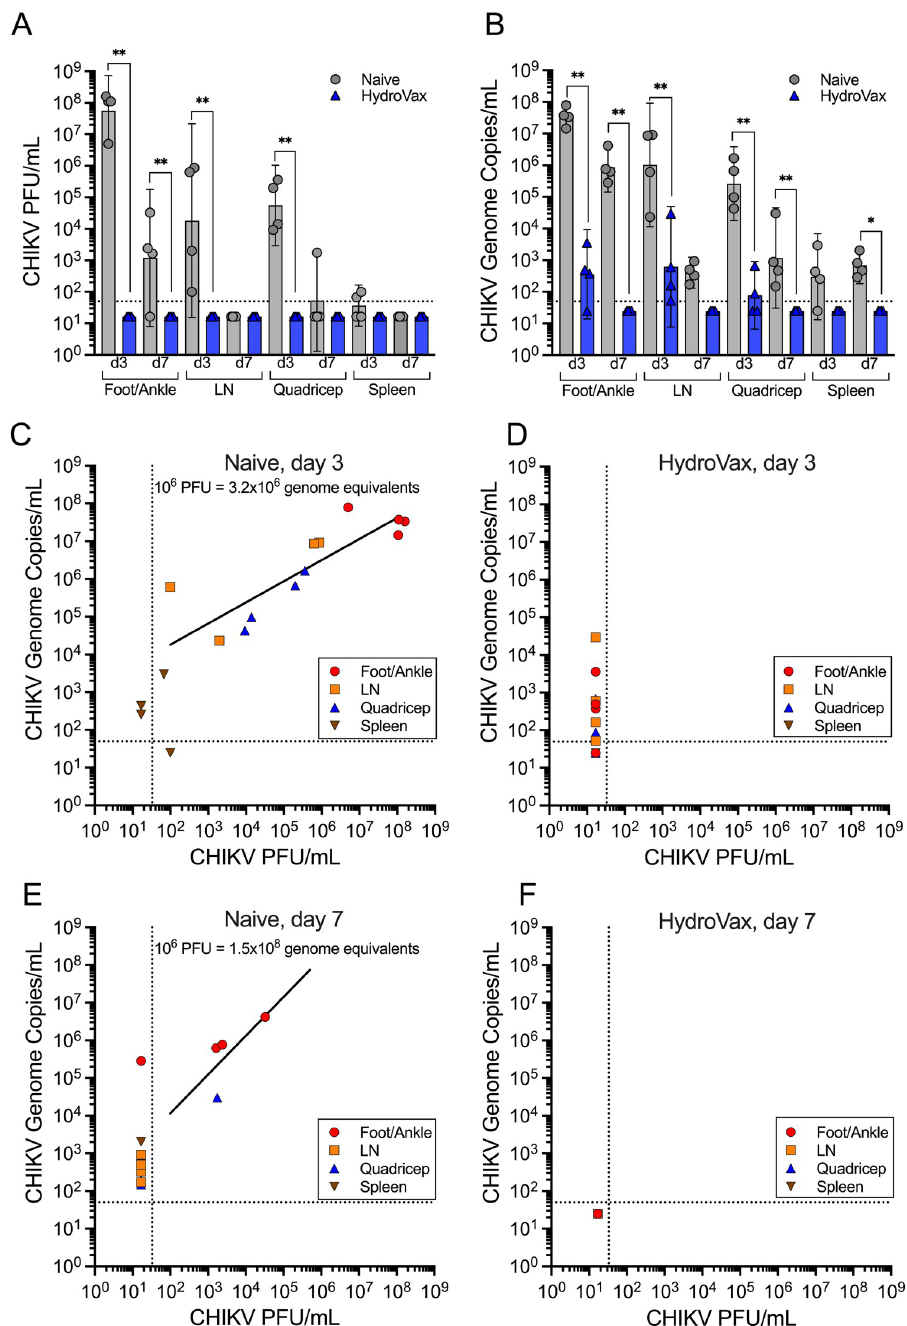
Fig 5. CHIKV dissemination is significantly reduced among HydroVax-immunized mice following heterologous challenge. Purified CHIKV-181/25 was inactivated with the optimized HydroVax approach (20 hours at room temperature) and formulated with alum adjuvant. C57BL/6 mice ( n = 8 mice per group) were immunized at 2 μ g per dose on days 0 and 28. At 56 days after primary immunization, mice were challenged in the footpad with 1,000 PFU of CHIKV-SL15649, along with age-matched na ï ve controls. At days 3 or 7 post-challenge, tissues from the challenge leg (foot/ankle, popliteal lymph node [LN] and quadricep muscle) and the spleen were collected from half of the animals in each group ( n = 4 per timepoint). Tissues were homogenized and assayed directly for (A) CHIKV virus titers or (B) further processed for RNA and assayed for CHIKV genome equivalents. RNA levels were normalized to the relative expression level of ribosomal protein S17 (RPS17). Pairwise comparisons were made between na ï ve and vaccinated groups at each time point in each tissue set using ANOVA with multiple test correction ( � , P < 0.05; �� , P <